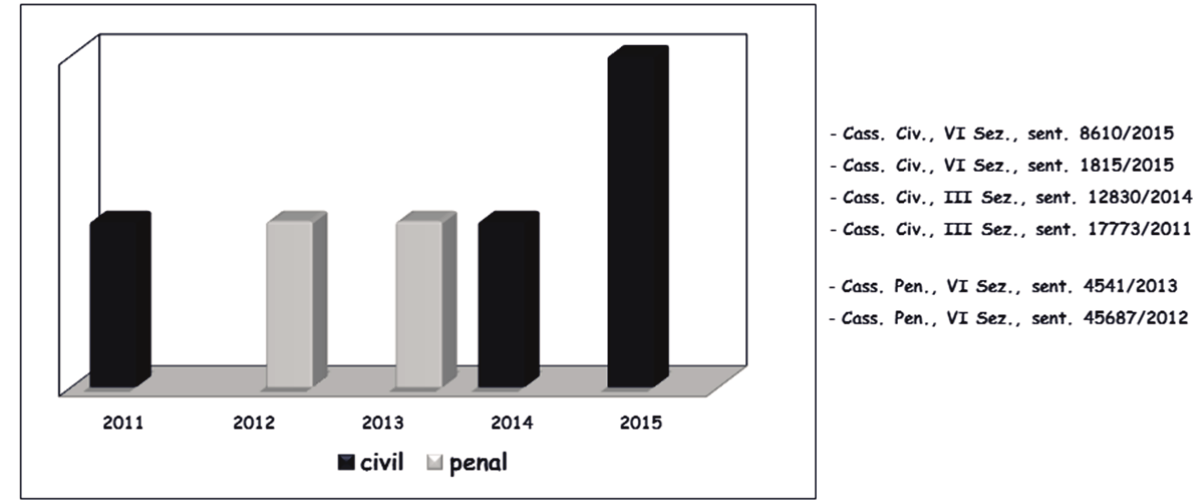
Figure 1: The attention devoted by the jurisprudence of ligitimacy to the process of information in heathcare treatments of an cosmetic nature in five-year period from 2011 to